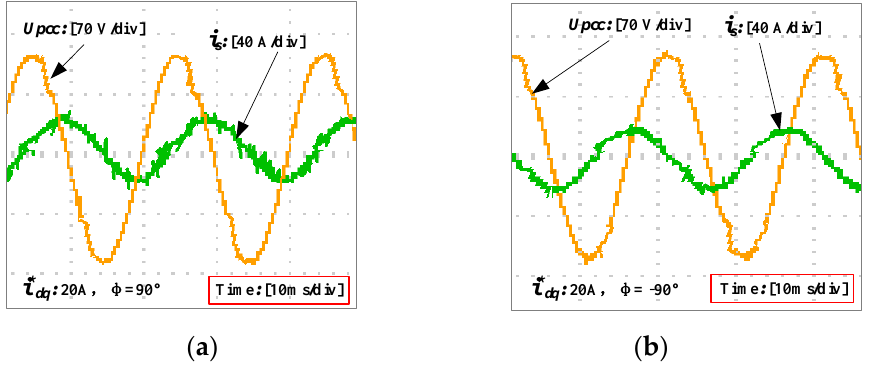
Figure 14. Waveforms of U PCC and i s with PLL. ( a ) Inductive reactive current ; ( b ) capacitive reactive current.